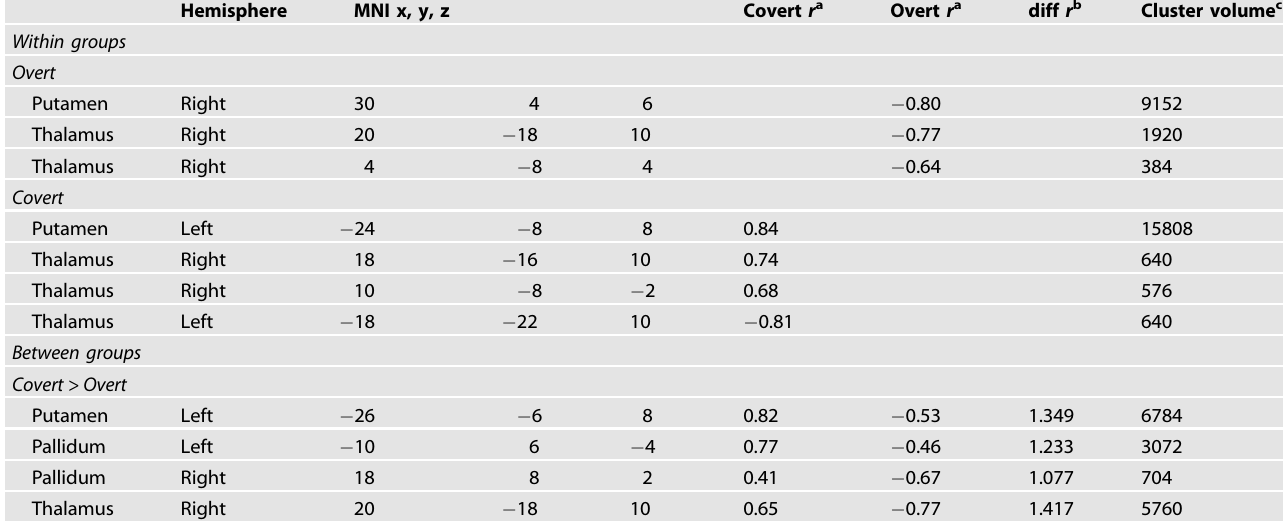
Table 2. Brain regions showing signi fi cant correlations between serotonin transporter occupancy and percent dopamine transporter binding potential change after overt and covert SSRI treatment.